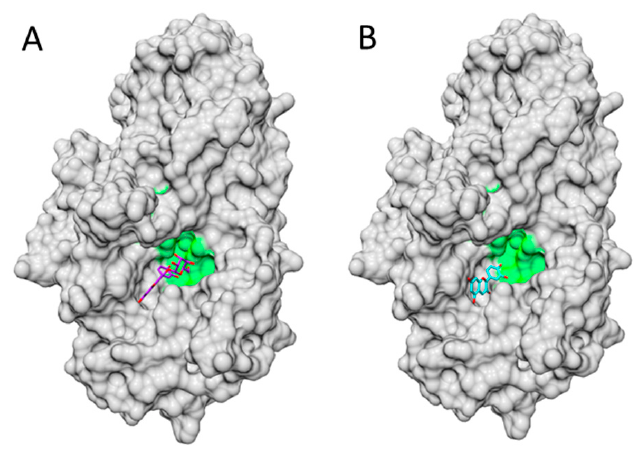
Figure 6. Docking simulation of Cy3G and Cy toward porcine amylase. Docking simulation details are described in Section 5.3. Cy3G ( A ); Cy ( B ) within enzyme’s ( light grey ) active site ( green ).